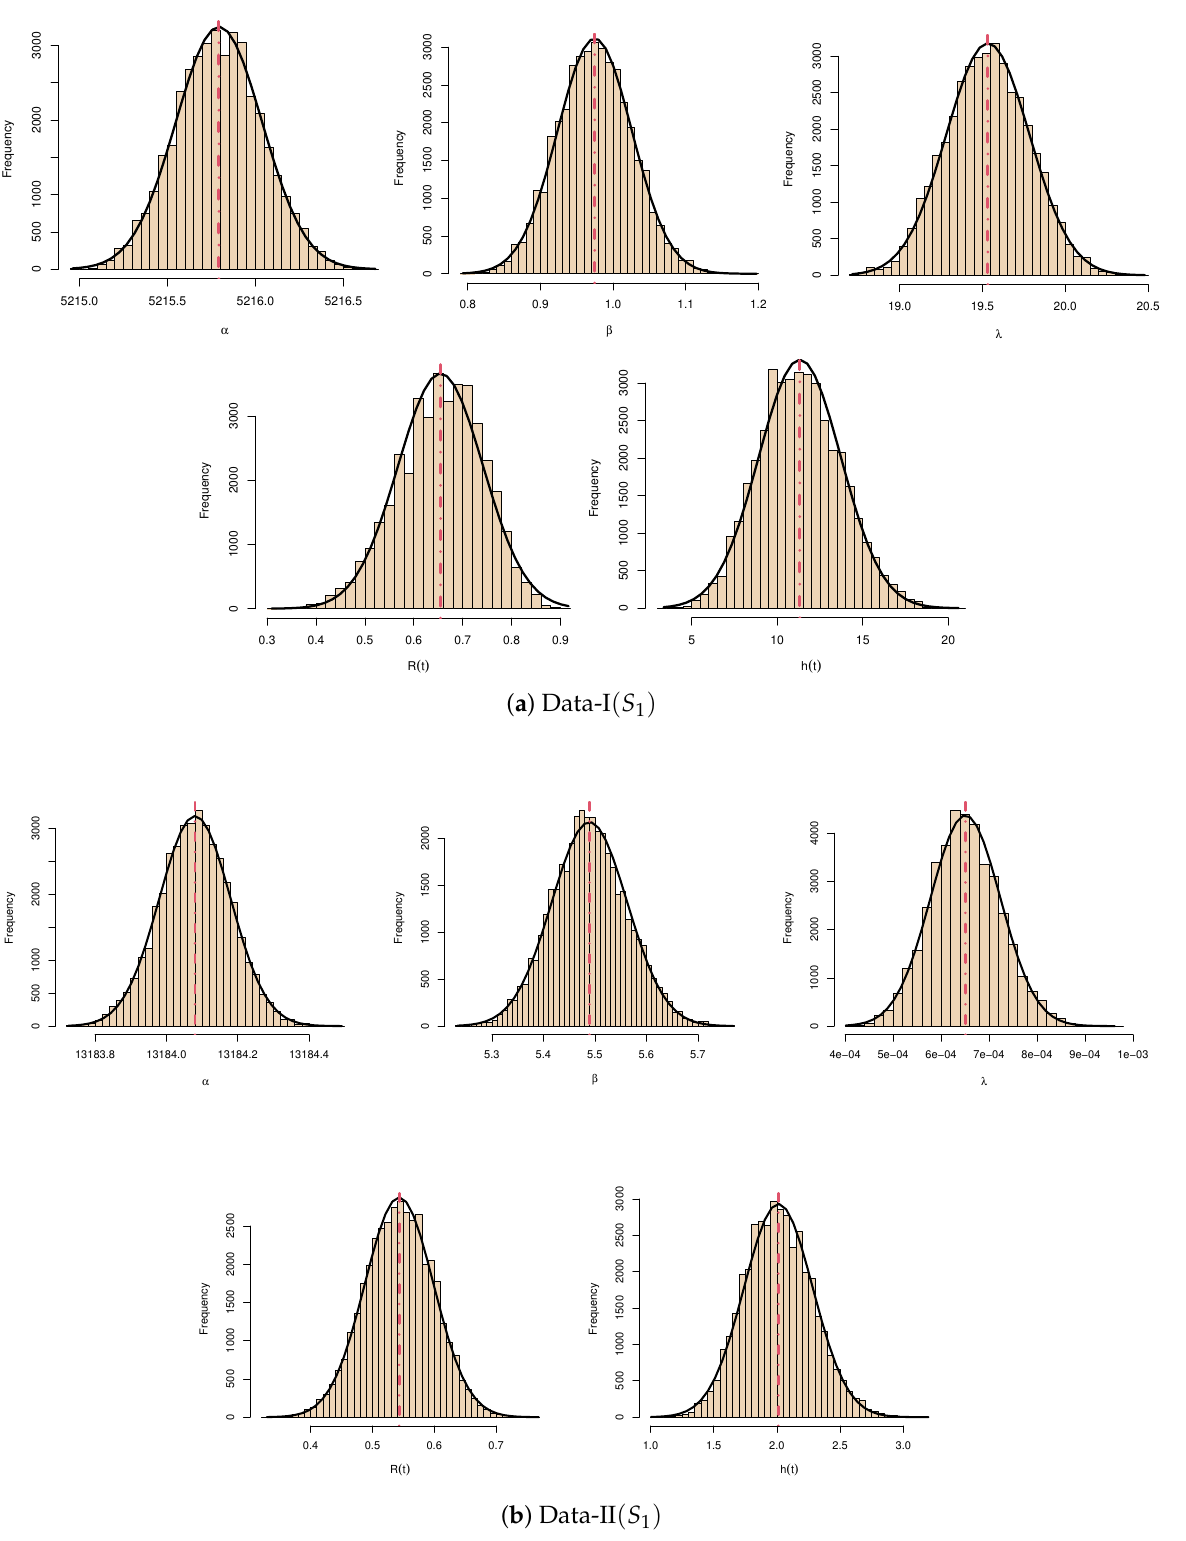
Figure 10. Histograms with estimated kernel density of α , β , λ , R ( t ) and h ( t ) under real data